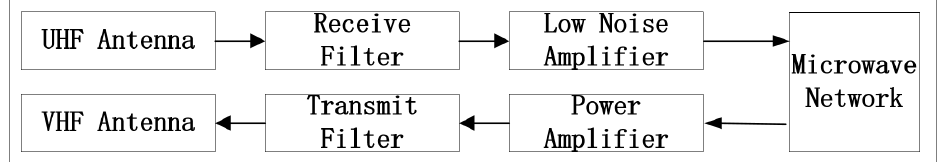
Figure 15. RF frontend flow.